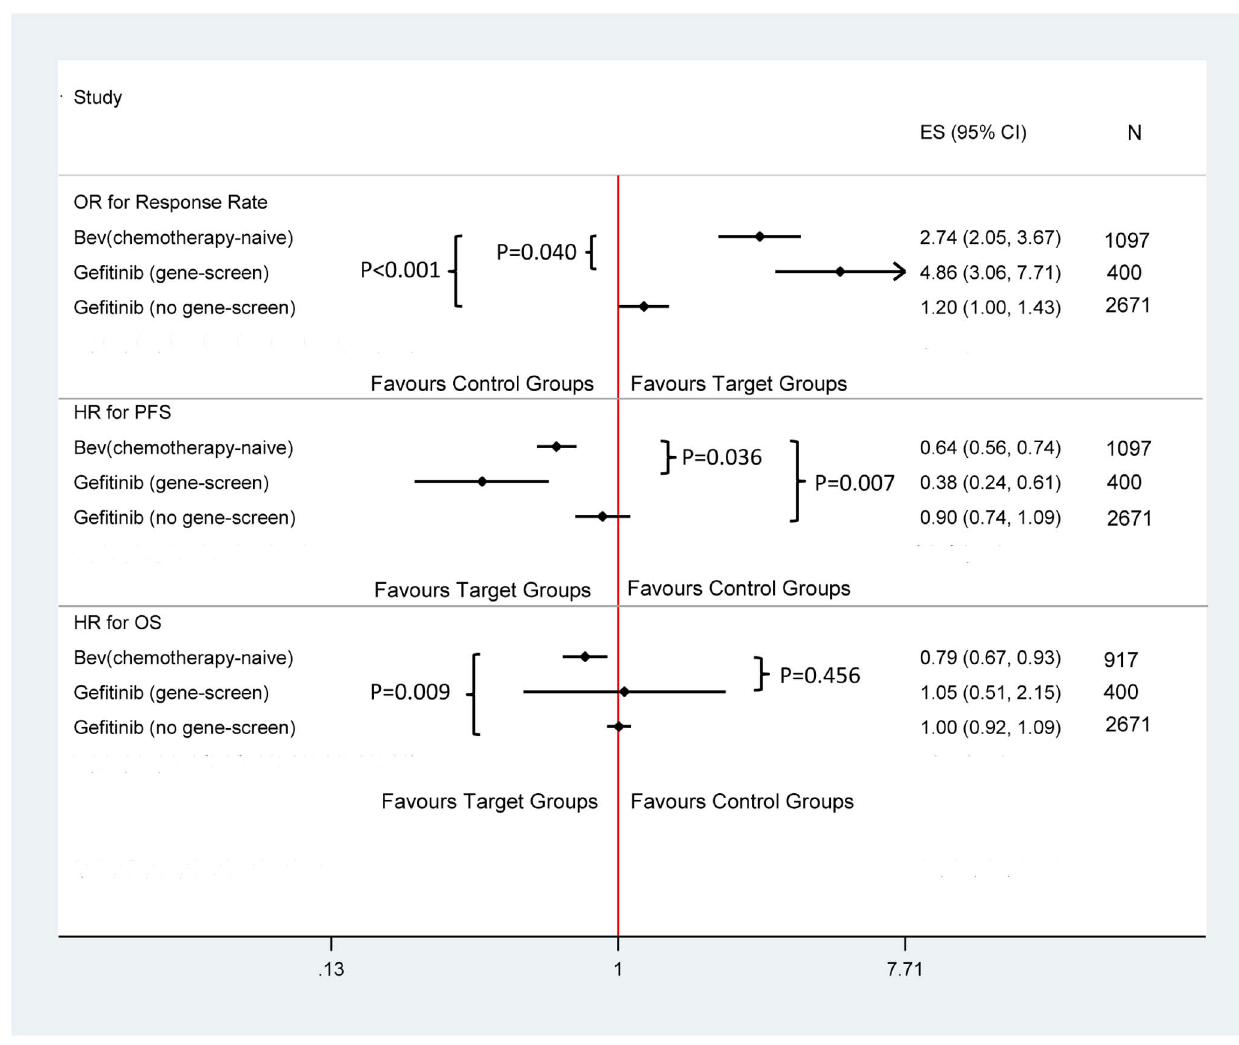
Figure 3. Response rate, PFS, OS of Bevacizumab versus Gefitinib in NSCLC patients with different EGFR status.